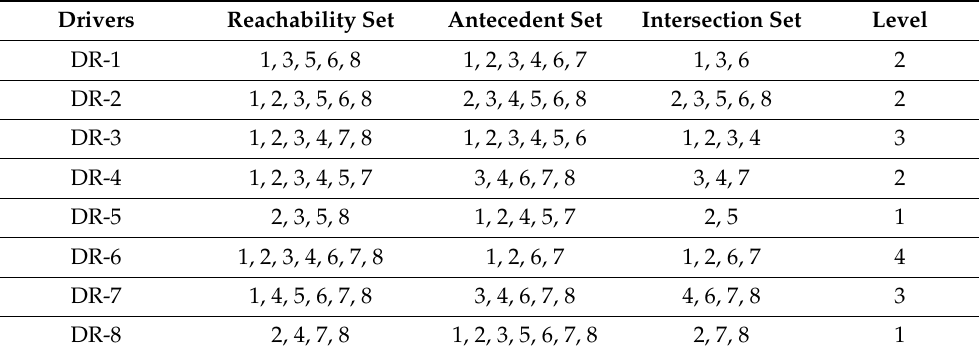
Table 3. Level partitioning matrix based on hierarchy